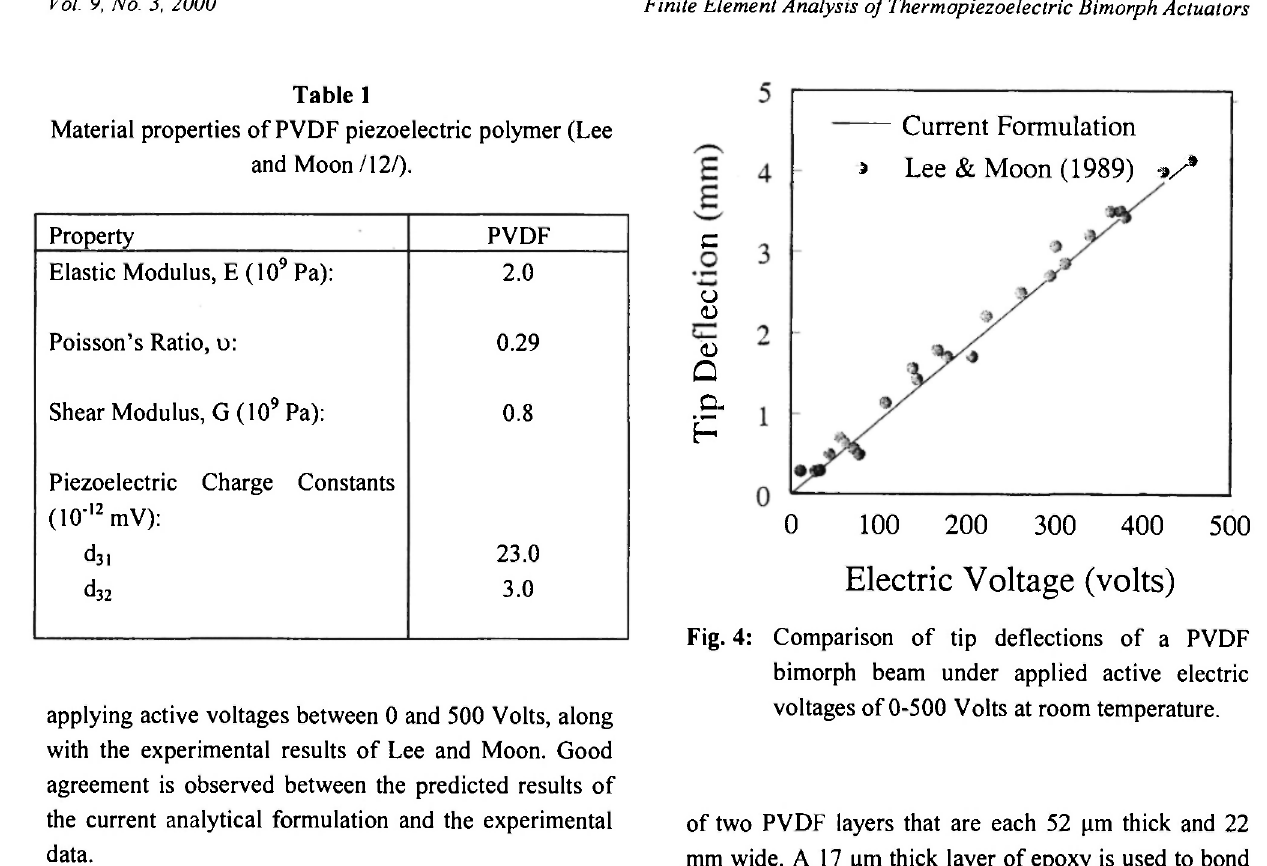
μπι thick and 17.5 mm wide silver electrode on the top and bottom surfaces. The force-displacement relation-